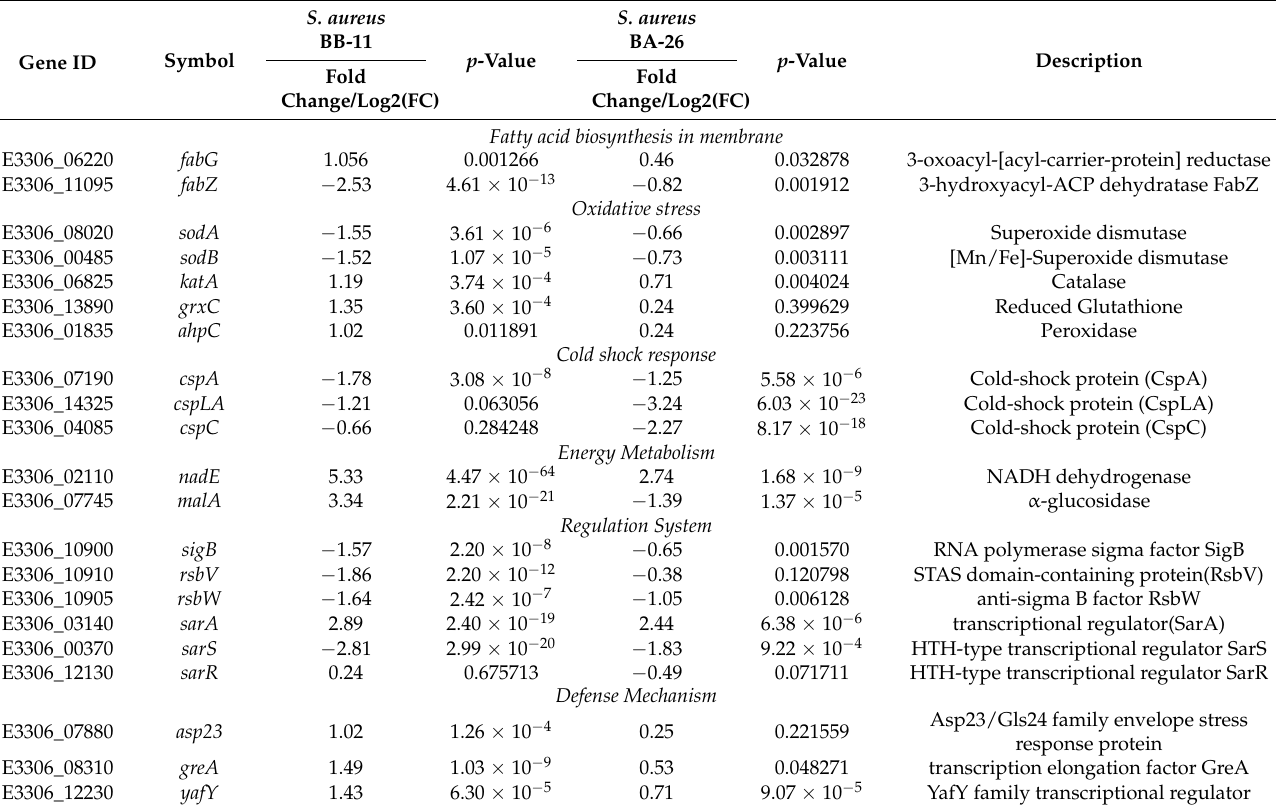
Table 2. Classification of DEGs of S. aureus involved in the response to cold temperature.